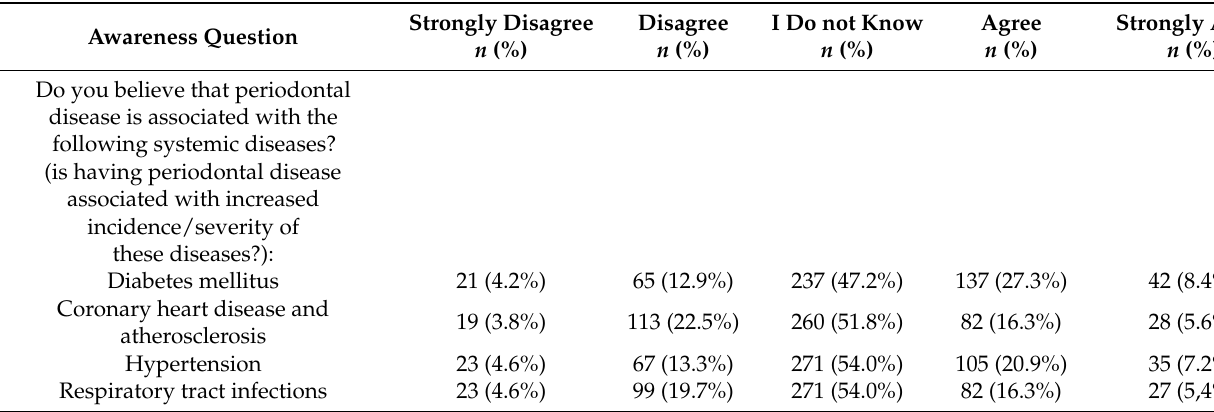
Table 3. Awareness of the study participants about the association between periodontal disease and systemic disease.